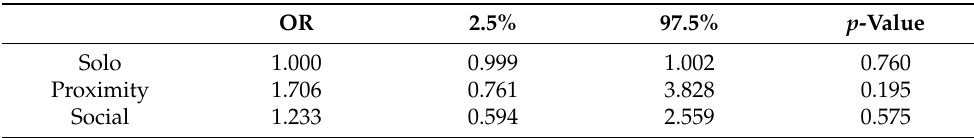
Table 5. Standard errors (SE), odds ratio (OR) with 95% CI, and z-statistics and p values for joint binary model.